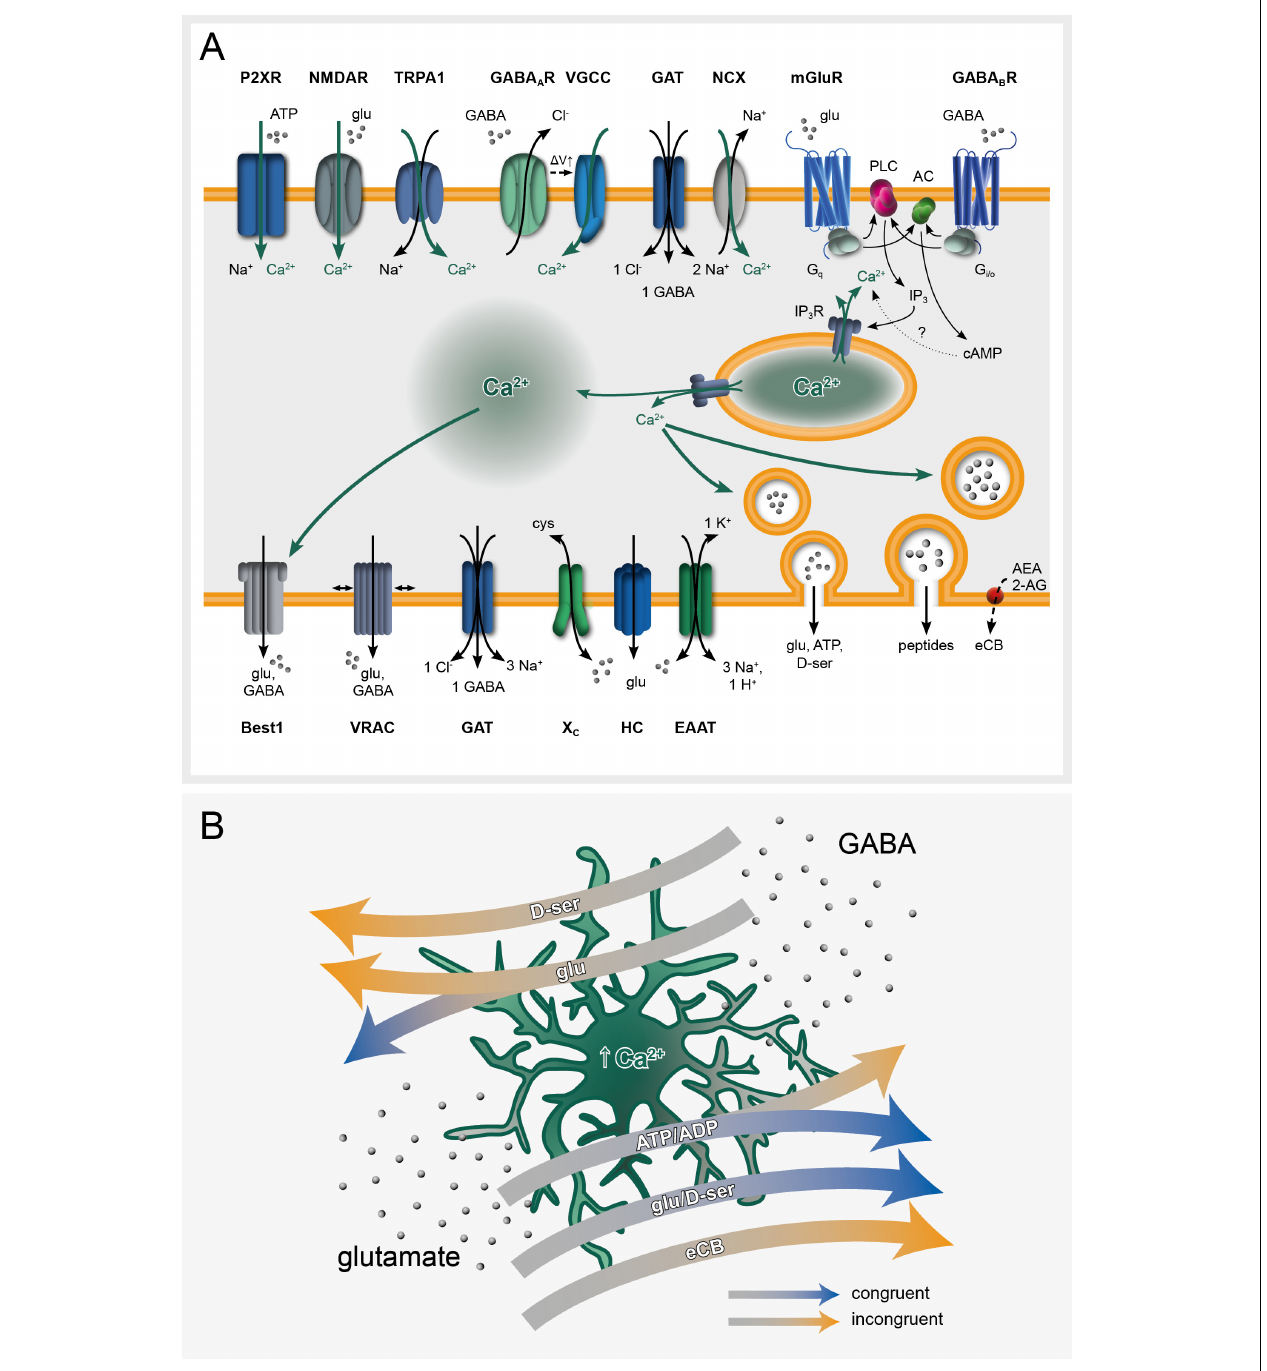
FIGURE 1 | Ca 2 + signaling at the core of astroglial black box operations. (A) Astroglial receptome coordinates glutamate and GABA-induced intracellular Ca 2 + signaling and subsequent gliotransmitter release. (B) Glutamate and GABA elicit Ca 2 + -dependent gliotransmitter-mediated congruent and incongruent modulation of network plasticity. Congruent signaling refers to contexts in which GABA and glutamate as initial stimuli exert inhibitory or excitatory effects on the neuronal network, respectively. Vice versa , incongruent signaling designates scenarios in which GABA has an excitatory and glutamate an inhibitory final impact on the network. Both congruent and incongruent signaling may involve the same gliotransmitters (highlighted on the arrows). 2-AG, 2-arachidonoylglycerol; AC, adenylate cyclase; ADP/ATP, adenosine di/tri-phosphate; AEA, anandamide; Best1, bestrophin-1 channel; cAMP, cyclic AMP; cys, cysteine; D -ser, D -serine; EAAT, excitatory amino acid transporter; eCB, endocannabinoids; GABA, γ -aminobutyric acid; GABA A R/GABA B R, GABA receptors; GAT, GABA transporter; glu, glutamate; HC, hemichannel; IP 3 , inositol triphosphate; IP 3 R, inositol triphosphate receptor; mGluR, metabotropic glutamate receptor; NCX, sodium-calcium exchanger; NMDAR, N-methyl- D -aspartate receptor; P2XR, purinergic transmitter-gated ion channels; PLC, phospholipase C; TRPA1, transient receptor potential A1; VGCC, voltage-gated calcium channel; VRAC, volume-regulated anion channel; X C , cysteine-glutamate antiporter; (cid:49) V, membrane potential.